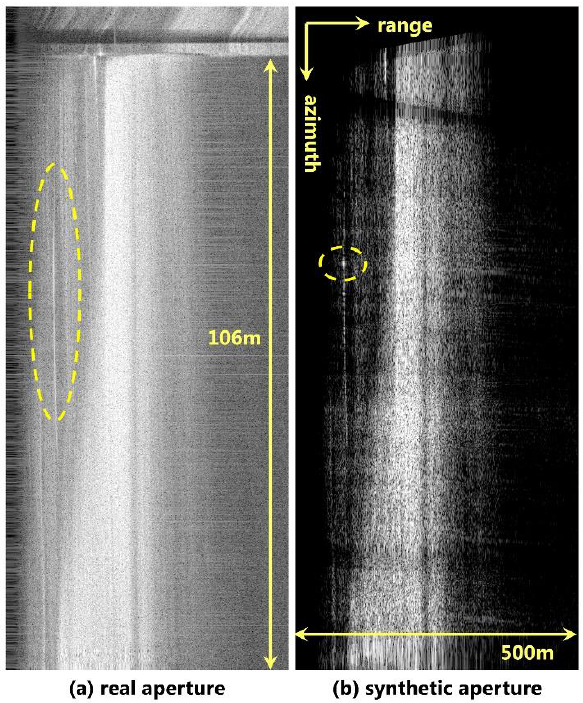
Figure 10. An example of focusing by synthetic aperture processing